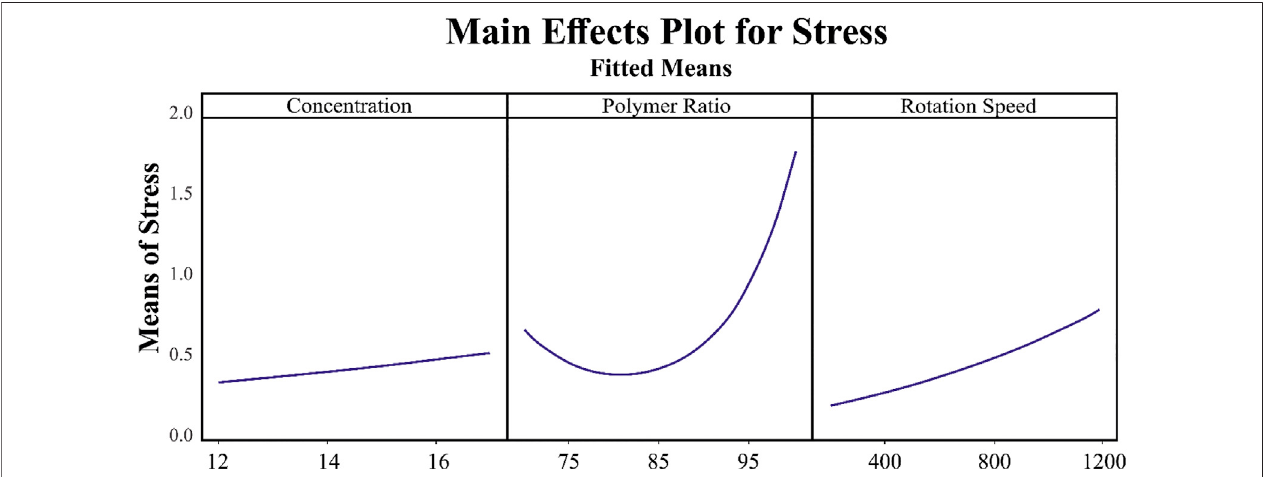
FIGURE 7 | Relation of the main parameters, concentration, polymer ratio, and rotation speed, with stress.